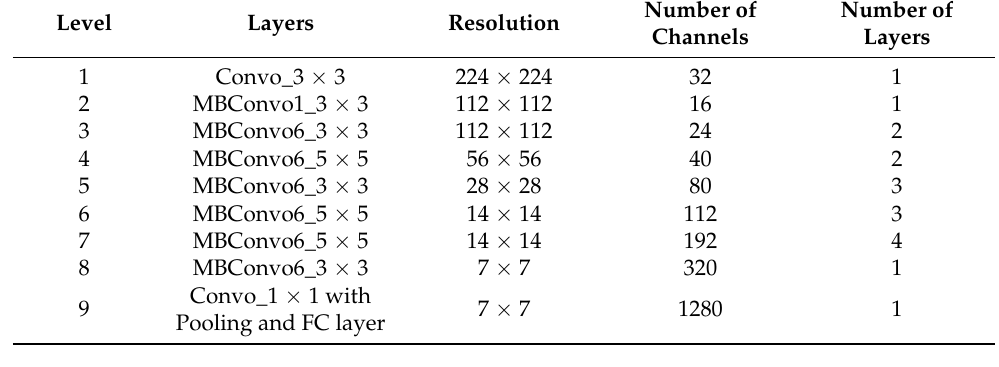
Table 3. Model layer and parameter categorization.